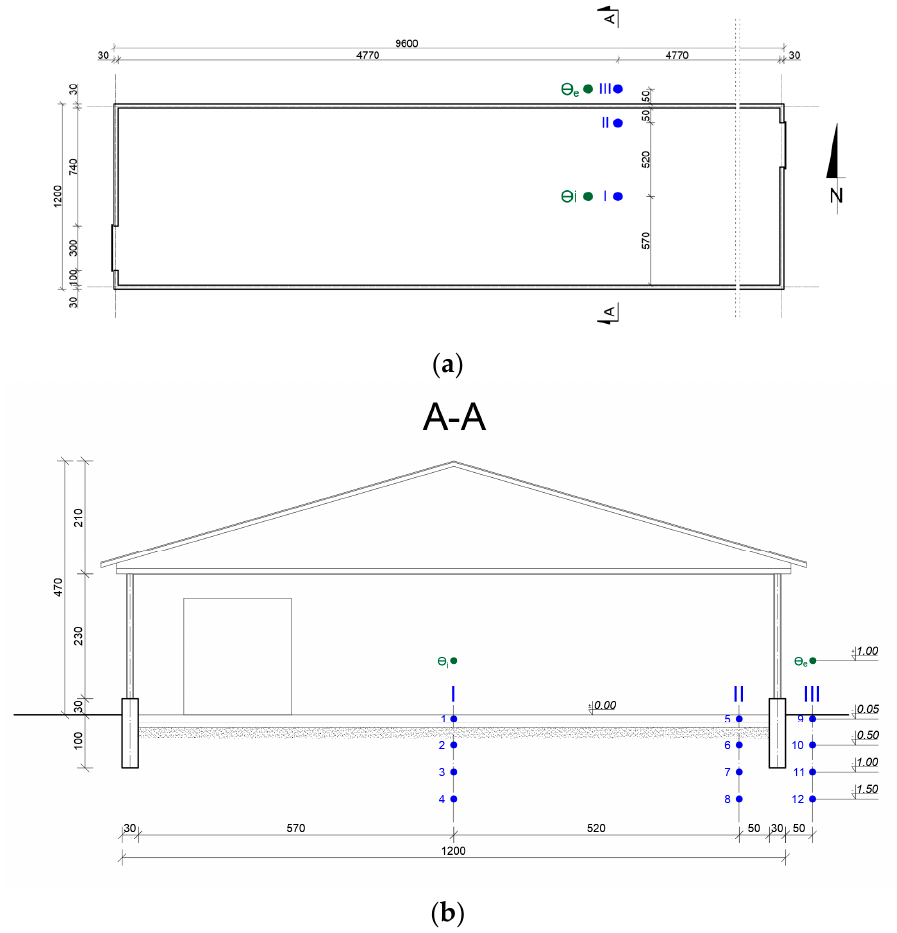
Figure 2. Plan view ( a ), cross-section of the tested object ( b ), and location of measuring points: Θ e —outdoor air temperature measuring point; Θ i —indoor air temperature measuring point; I, II, III—measuring vertical sections; 1, 2...12—ground temperature measuring points.